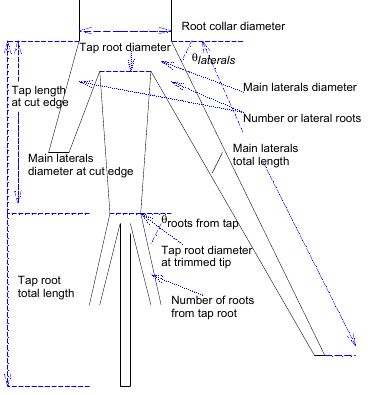
Table 5. Mean ( ± SD) aboveground data of Moringa oleifera , Ricinus communis , and Jatropha curcas , and their environmental conditions documented during previous research at the site.